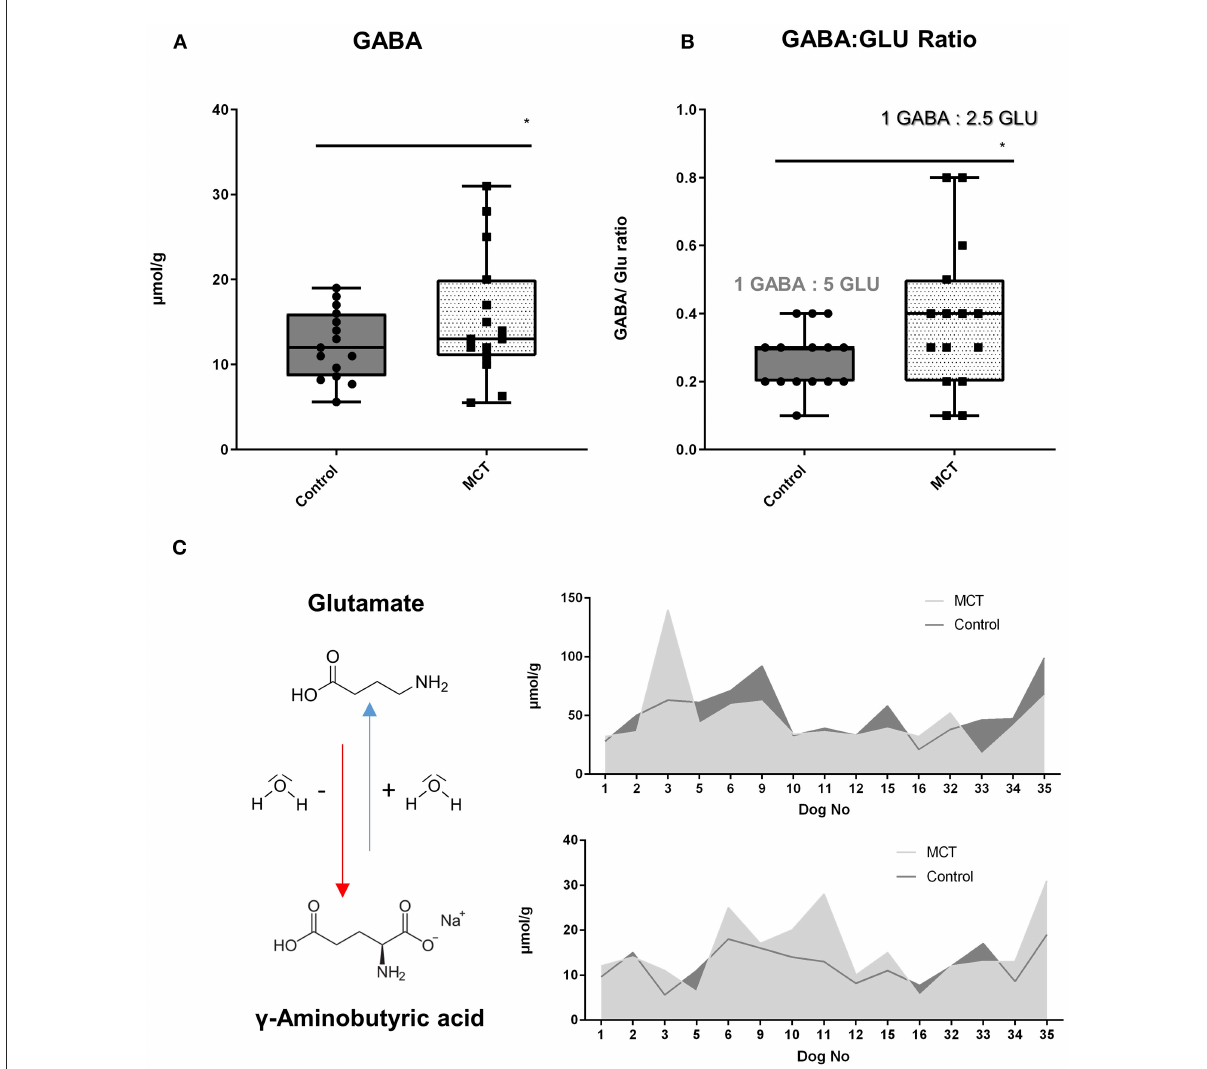
FIGURE2 Urinary neurotransmitter profile: Effect of the medium-chain TAG dietary supplement (MCT-DS, light pointed) on the γ -Aminobutyric acid (GABA)—glutamate balance in urine compared with the control dietary supplement (Control-DS, dark-grey). Significant (A) increased γ -aminobutyric acid (GABA) concentrations ( P = 0.0044) and a shift in the GABA/glutamate ratio (B) during the MCT phase was found ( P = 0.0025). A predominant shift to the GABAeric side in the GABA/glutamate ratio (C) was observed under MCT-DS consumption (light grey) compared to the Control DS (dark-grey). Data are shown as box-and-whisker plots (central lines of the box represent the median, lower and upper limits of the box represent the 25th and 75th percentiles and whiskers represent the minimum and maximum). Two-sided Wilcoxon’s matched-pairs rank tests were used to compare control and MCT-DS groups. * P <